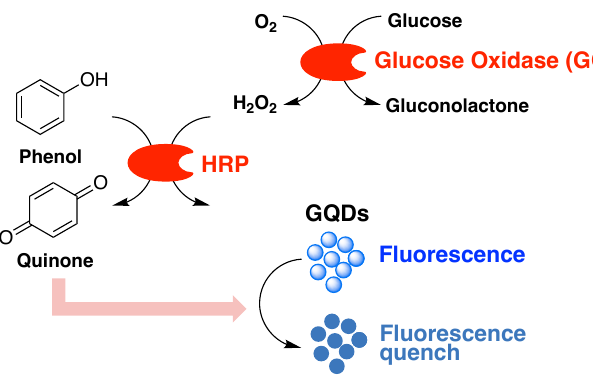
Figure 1. The transmission electron microscopy (TEM) image of